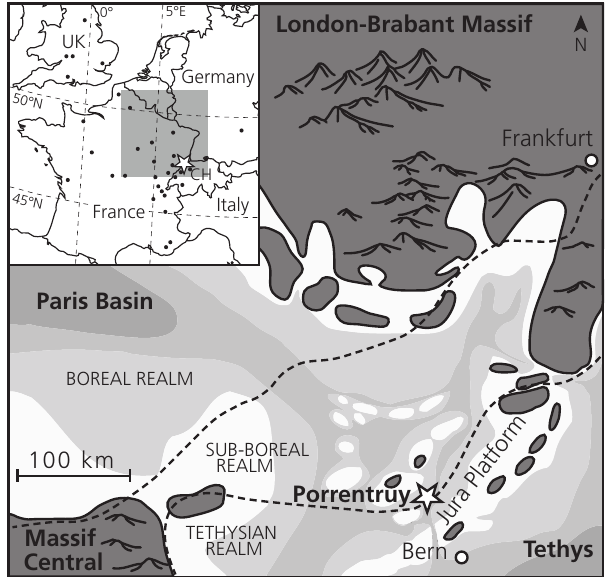
Figure 1. Palaeogeographical map of the study site and sur- roundings (Late Kimmeridgian, modified from Comment et al., 2011). CH = Switzerland, palaeolatitude of Porrentruy =∼ 30 ◦ N. Emerged land is outlined, darker grey corresponds to deeper water. Upper left corner: present-day geographical position of Porrentruy ( (cid:63) ) and other European sites ( • ) of previously published studies and providing geochemical data compared in Fig. 5. The shaded square delimits the area detailed in the palaeogeographical